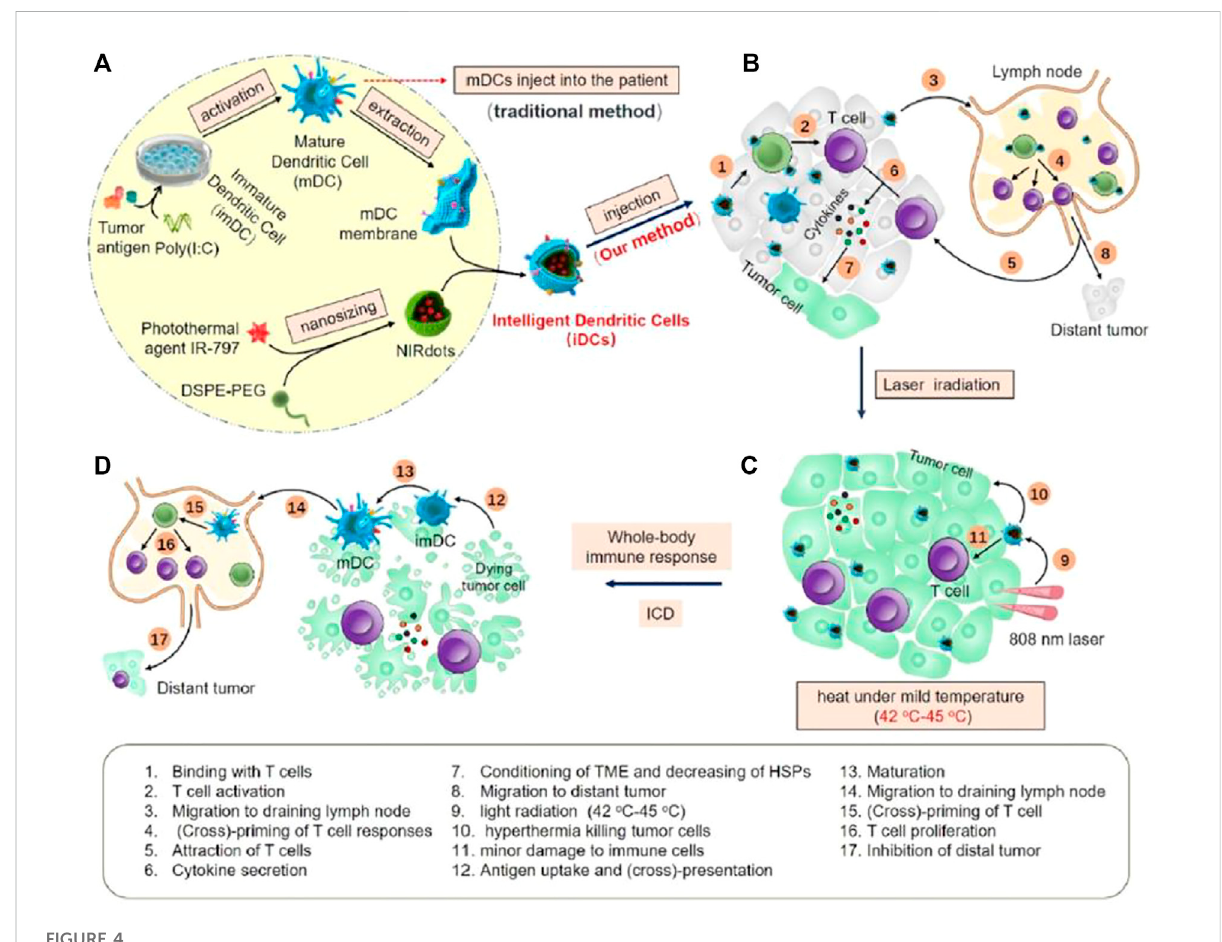
FIGURE 4 The schematic of iDCs activating T cells and mediating hypothermic PTT. (A) The construction of iDCs. (B) iDCs injected intratumorally to primary tumor. (C) iDCs enhanced low temperature PTT. (D) iDCs induced synergistic antitumor effect (Sun Z. et al.,